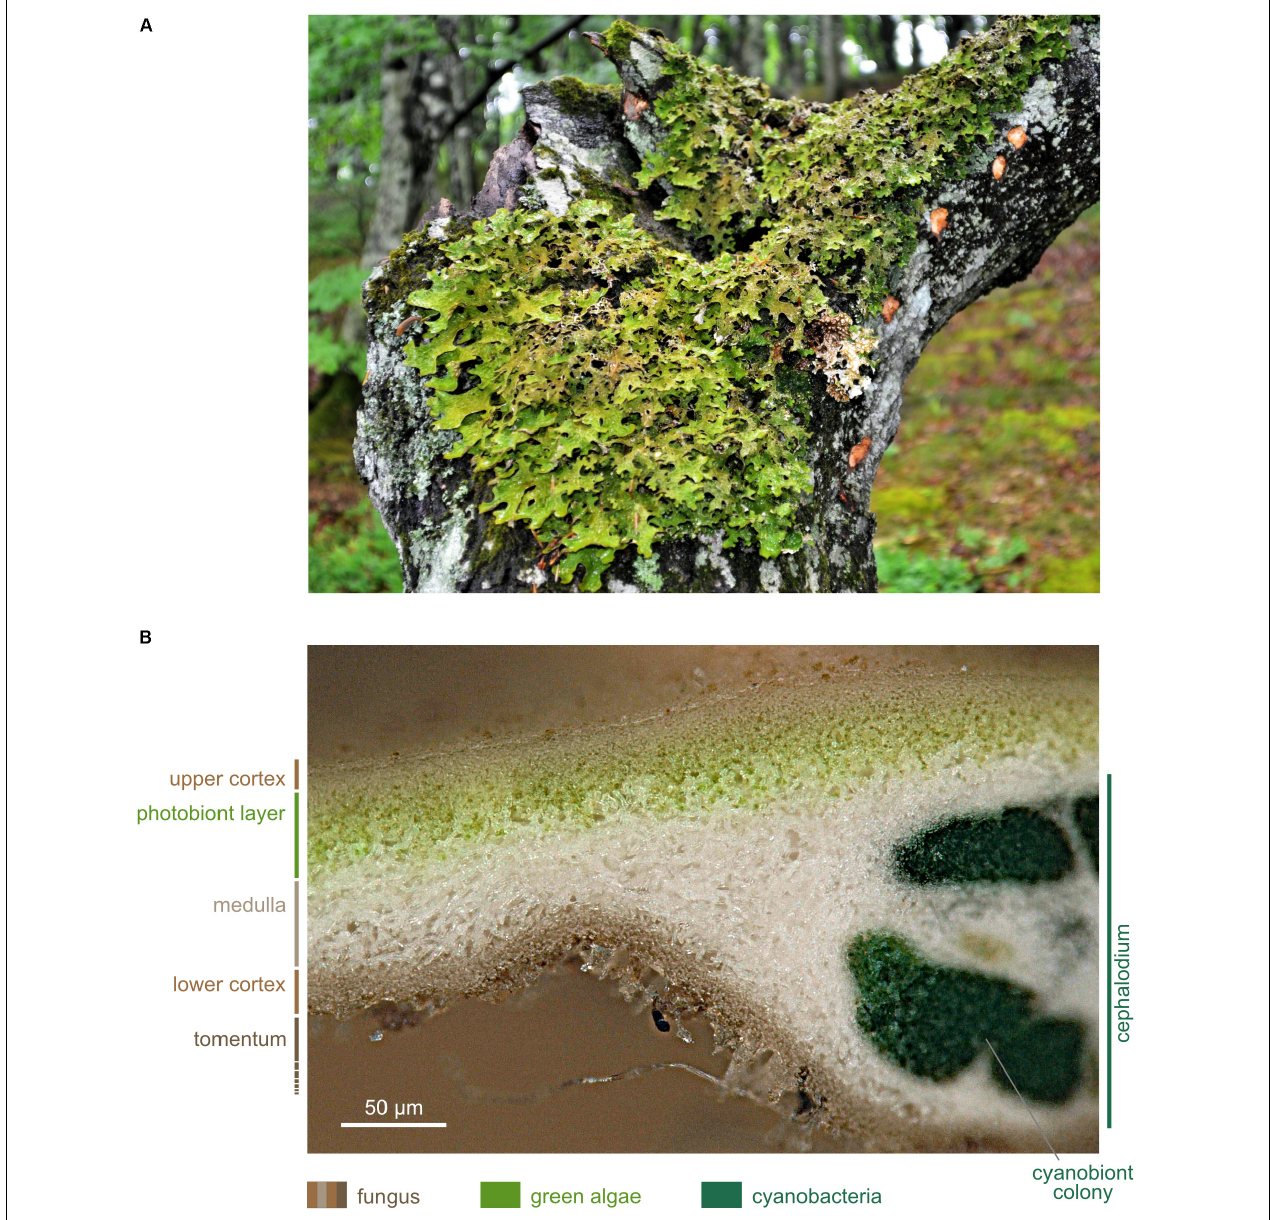
FIGURE 2 | Lobaria pulmonaria . (A) Specimen growing on Fagus sylvatica (photographed in May 2016 near Viborg, Denmark); (B) Microscopic cross section. The upper cortex forms the habitat of the microbiome. Image produced with dry, sectioned material using a Keyence Digital VHX-5000 microscope with automated image